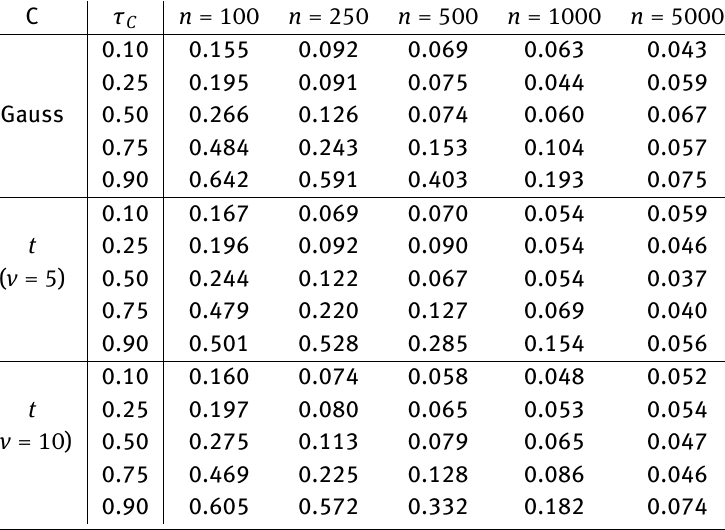
Table 5: d = 6 : Empirical level of the test for ellipticity with significance level α = 0.05 based on the test statistic T n : rate of rejecting H 0 as observed in 1000 random samples of size n from copula family C with Kendall’s tau τ C